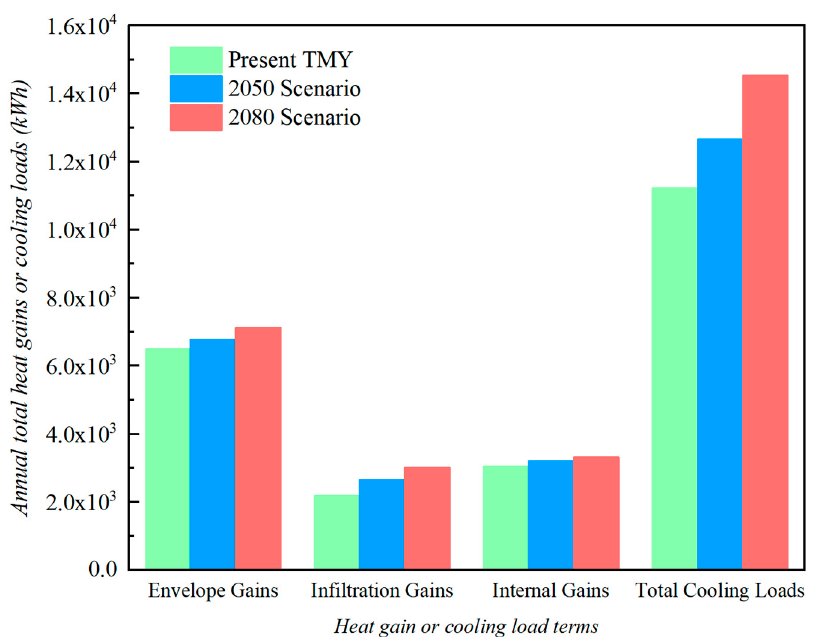
Figure 14. Heat gain terms of the total cooling loads of present TMY and predicted future scenarios (2050 and